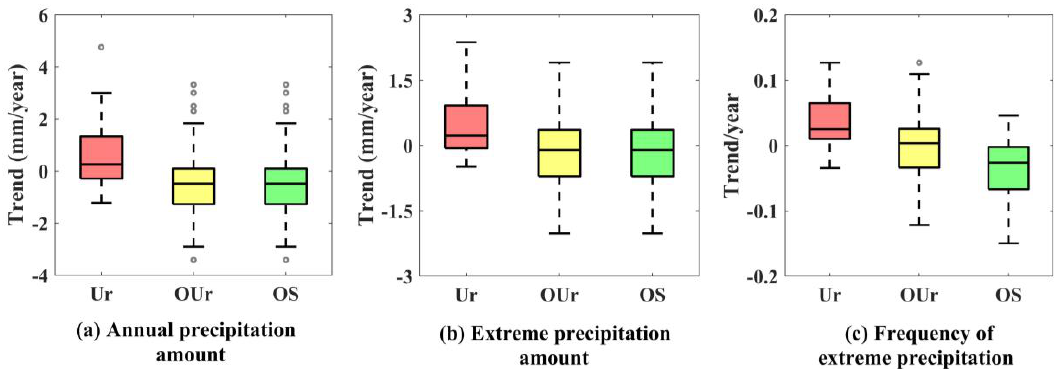
Figure 7. Box plots of the precipitation trends during 1979 – 2010 for Ur, OUr and OS. The rectangular box plot shows three horizontal lines that represent the median (intermediate line), the 25th percentile (low line) and the 75th percentile values (upper line), while the top and bottom three vertical lines represent the maximum and minimum of the precipitation changes during 1979 – 2010 for Ur, OUr and OS, respectively. ( a ) annual precipitation amount; ( b ) extreme precipitation amount; and ( c ) frequency of extreme precipitation.